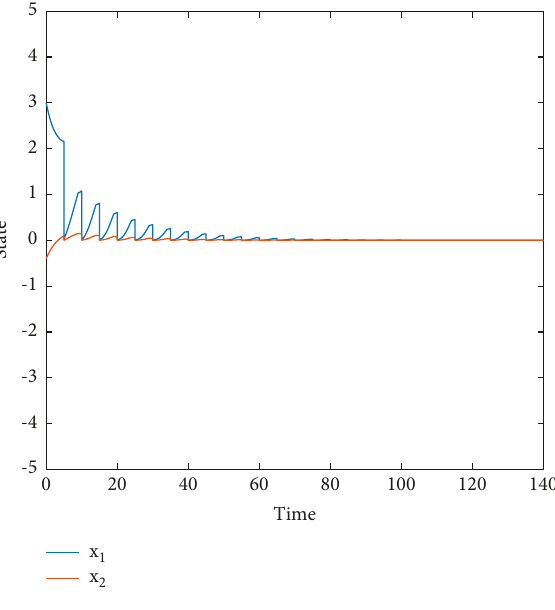
Figure 1: The state of (39) and (40) with τ � 4.